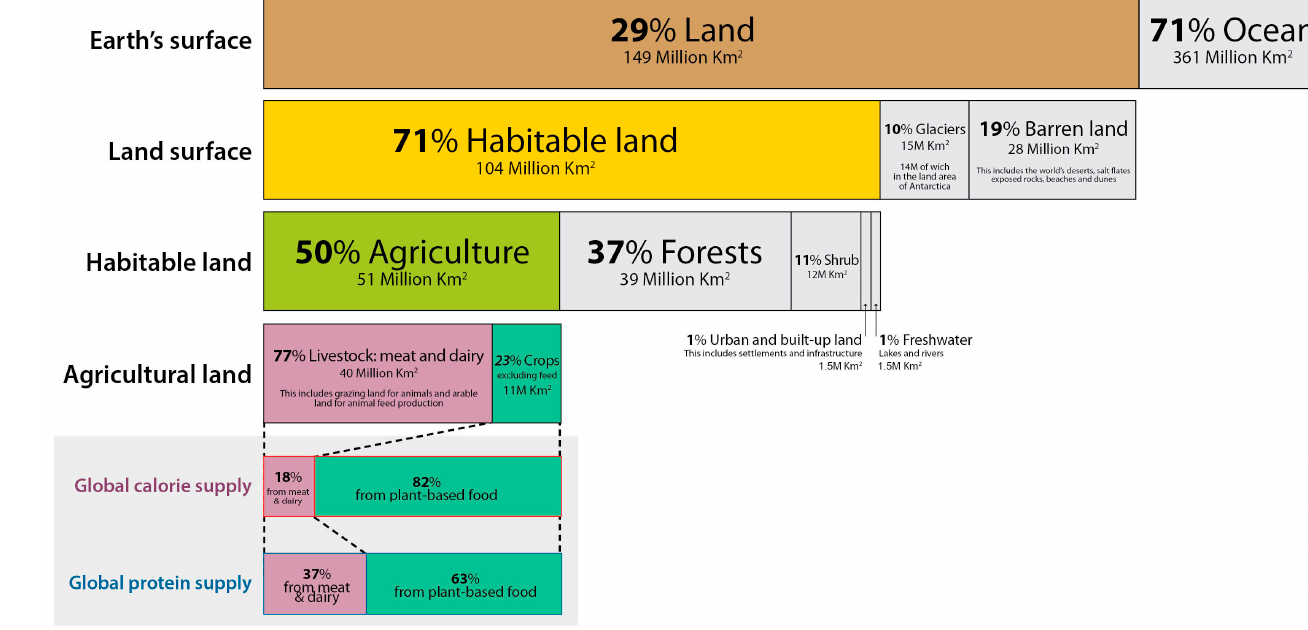
Figure 1. Land Use (Open-source under the CC-BY License) [7].